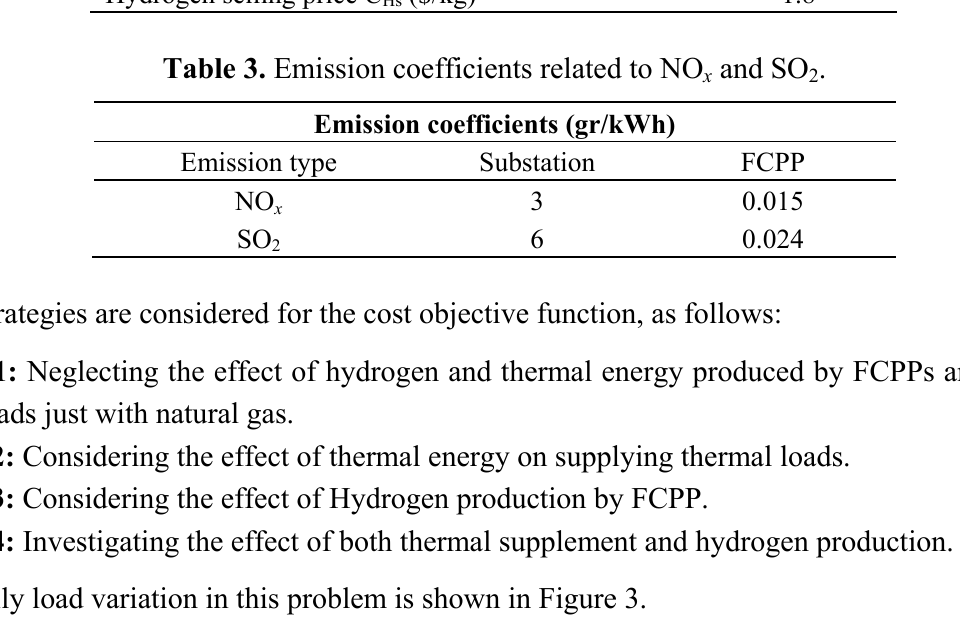
Table 3. Emission coefficients related to NO